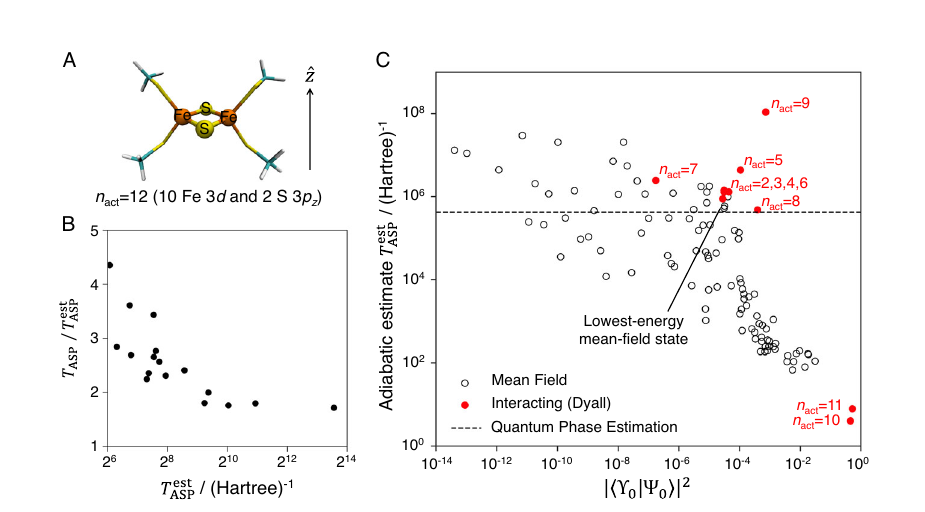
Fig. 1 | Ansatz state preparation and ansatz weights for model Fe-S clusters. A Structural models of [2Fe-2S], [4Fe-4S], P-cluster, and FeMo-co. B Weight of two differenttypesofansatzstate:largestweightdeterminant( Φ D )(purple)andlargest weight con fi guration state function ( Φ CSF ) (orange) asa function of the number of metalcentersineachcluster(usingsplit-localizedorbitals).P N ,P syn ,P ox herereferto